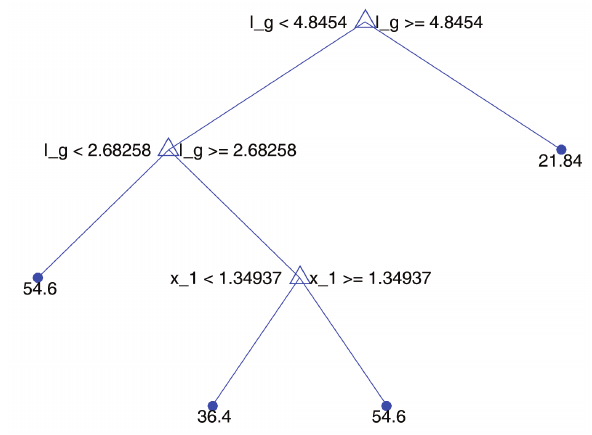
Figure 5. Binary decision tree of the estimated load based on the current measurement of generator